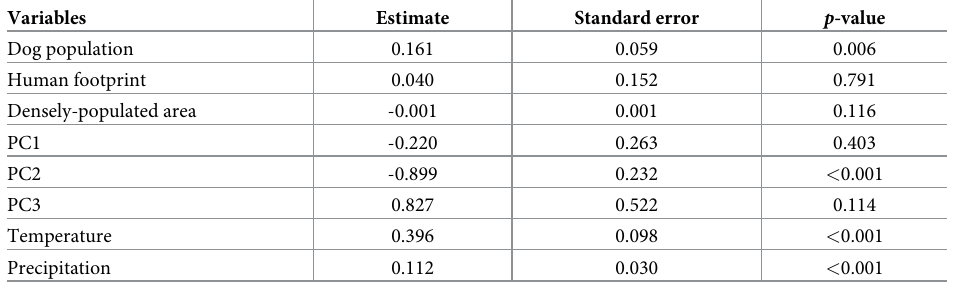
Table 6. Univariable analysis results for dog rabies cases in South Africa between 2008 and 2012 including the Kruger National Park. Variables